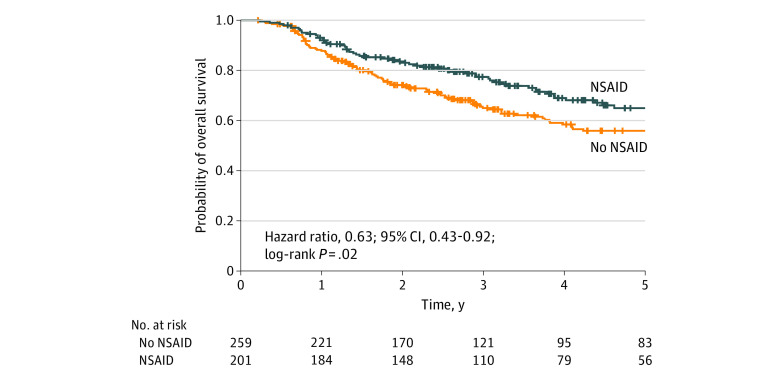
OS for Patients Taking NSAIDs vs Patients Not Taking NSAIDsNSAID indicates nonsteroidal anti-inflammatory drug.